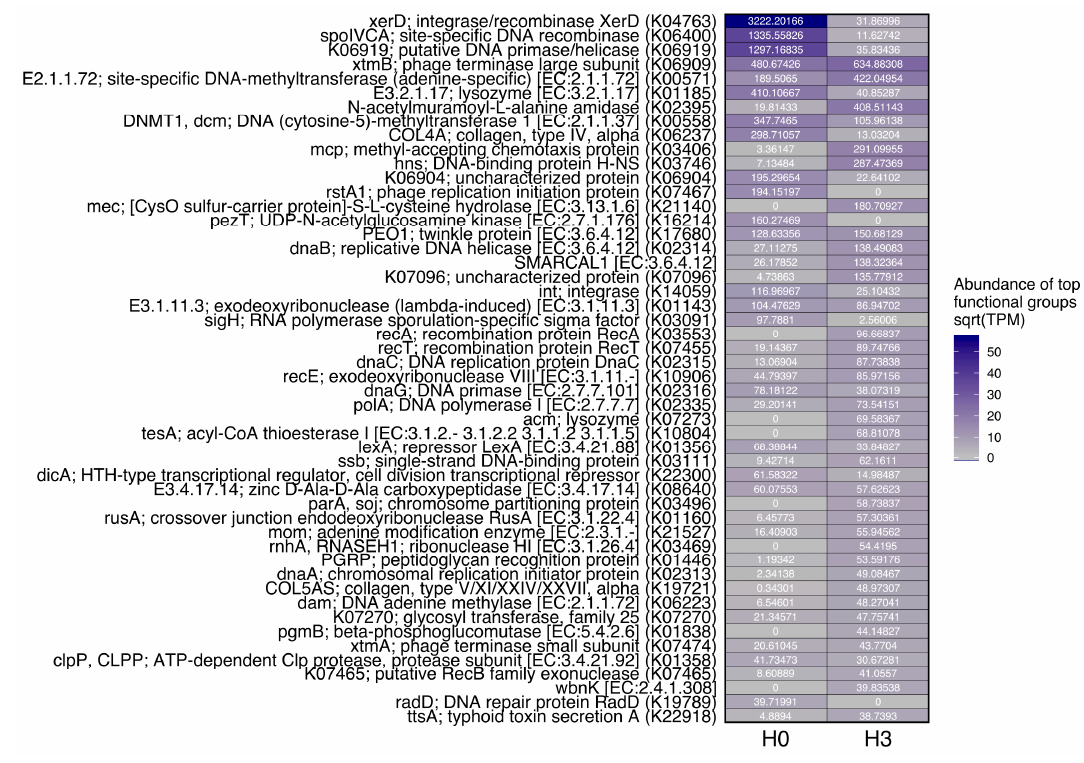
Figure 4. Viral genes heatmap generated with VIBRANT.